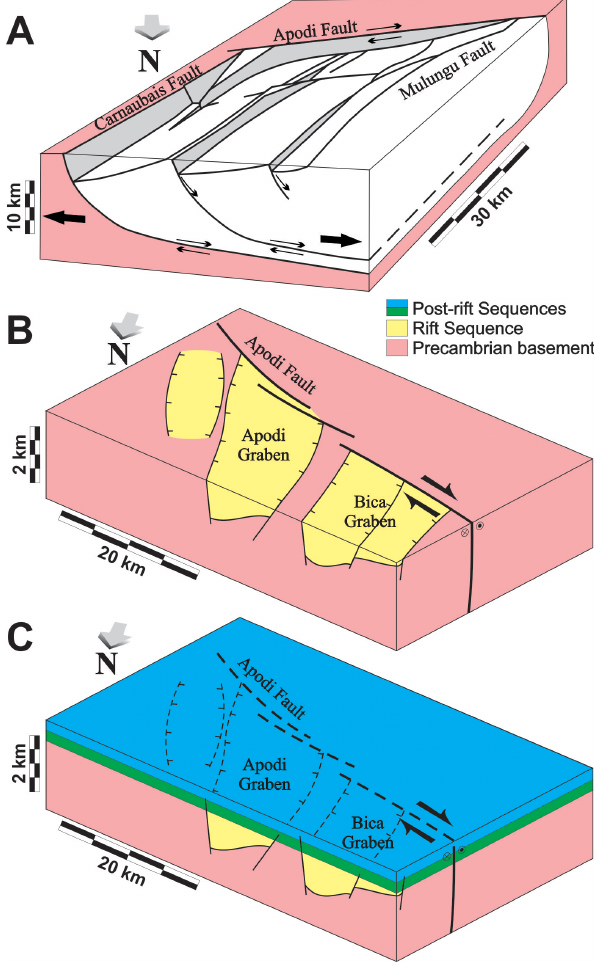
Figure 11. Illustration of (a) the main framework of the Potiguar Basin proposed by Matos (1992) (modified from Rodrigues et al., 2014); (b) the geometry and kinematics of the Apodi faults and the N–S-trending graben during the rift phase and (c) the postrift